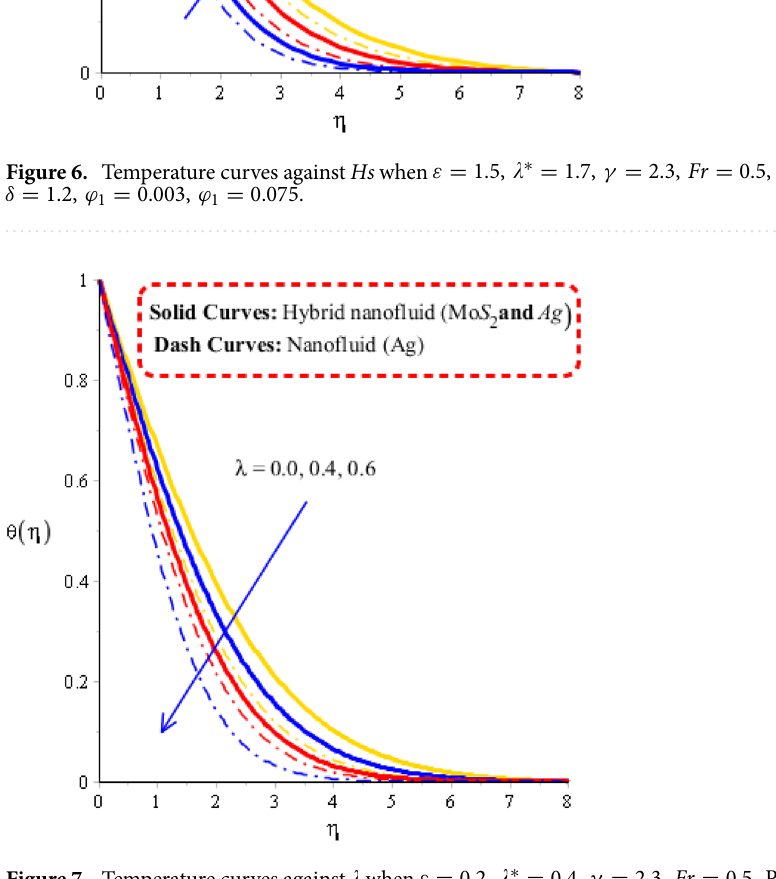
Figure 7. Temperature curves against (cid:31) when ε δ = 3.0, ϕ 1 = 0.003, ϕ 1 =